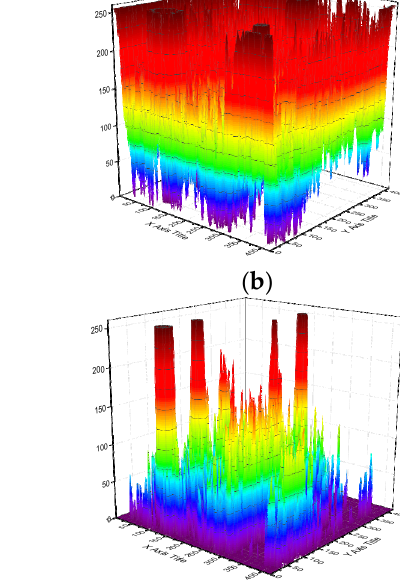
Figure 7. The SNR for each size-to-depth ratio of the defect.